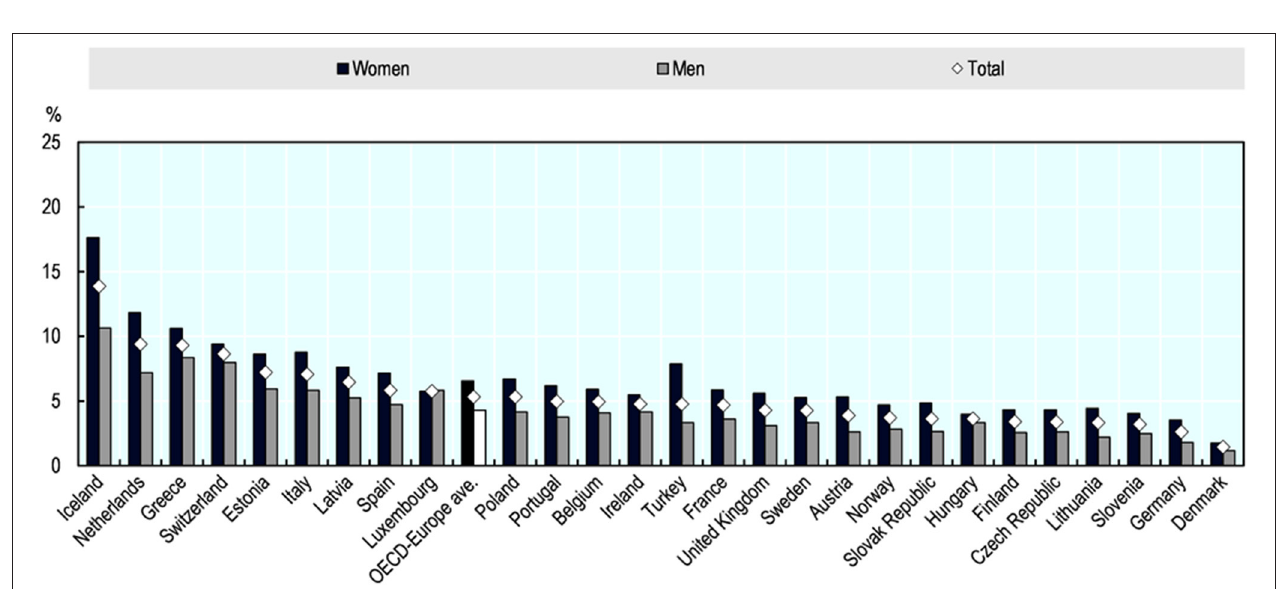
FIGURE 1 | Frontline jobs, which are deemed “essential” and require people to work in-person, are heavily staffed by women. The healthcare, social work, and government and community-based services sectors are overwhelmingly made up of female employees, according to research from the Economic Policy Institute